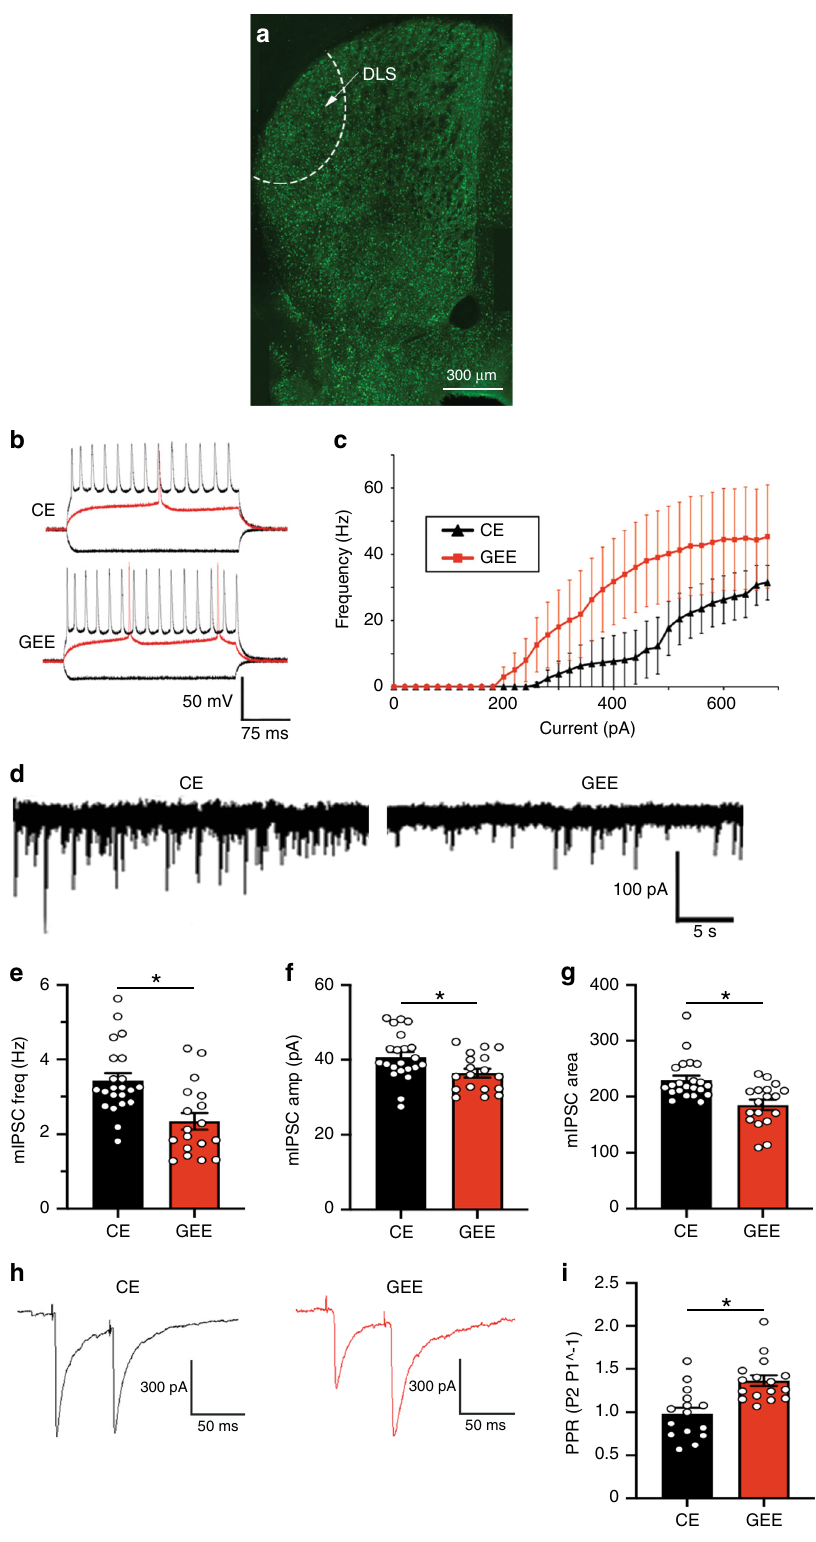
Fig. 4 GEE increases MSN excitability and decreases GABAergic transmission onto DLS MSNs. a GAD65-GFP slice with the DLS demarcated. b Response of MSNs to hyperpolarizing (bottom black), just suprathreshold (middle red), and strongly depolarizing (top black) currents from CE (top), injected current = − 400, + 300, and + 600 pA, respectively, and GEE (bottom) current = − 400, + 220 and + 600 pA, respectively. c Current-AP frequency relationship shows an increase in the max frequency of AP in GEE compared to CE. d Representative mIPSCs recorded from CE and GEE MSNs. Graphs showing that mIPSC e frequency, f amplitude, and g area are decreased in GEE compared to CE. h Representative paired-pulse traces from CEE and GEE DLS-MSNs. i Paired-pulse ratio of DLS-MSNs recorded from CE and GEE mice with interstimulus interval of 50 ms. Error bars equal ± SEM, * t -test = p <